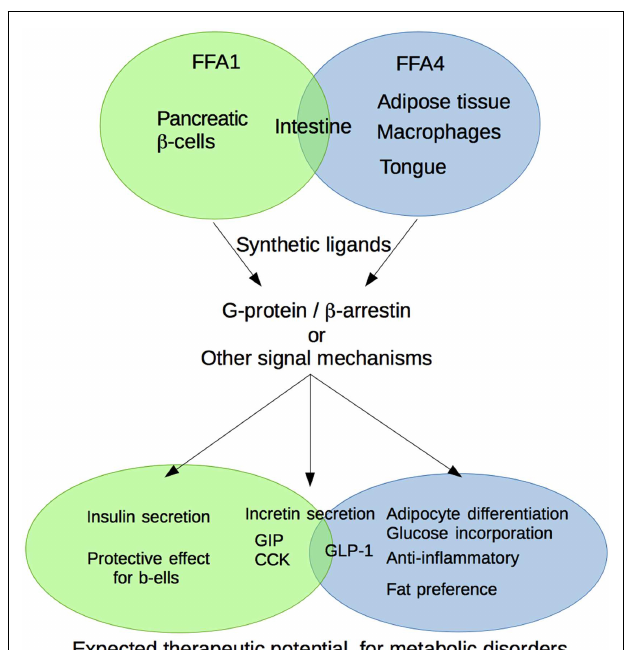
FIGURE 1 | Schematic diagram of the physiological function of medium- to long-chain fatty acid receptors FFA1 and FFA4 related to the metabolic regulation